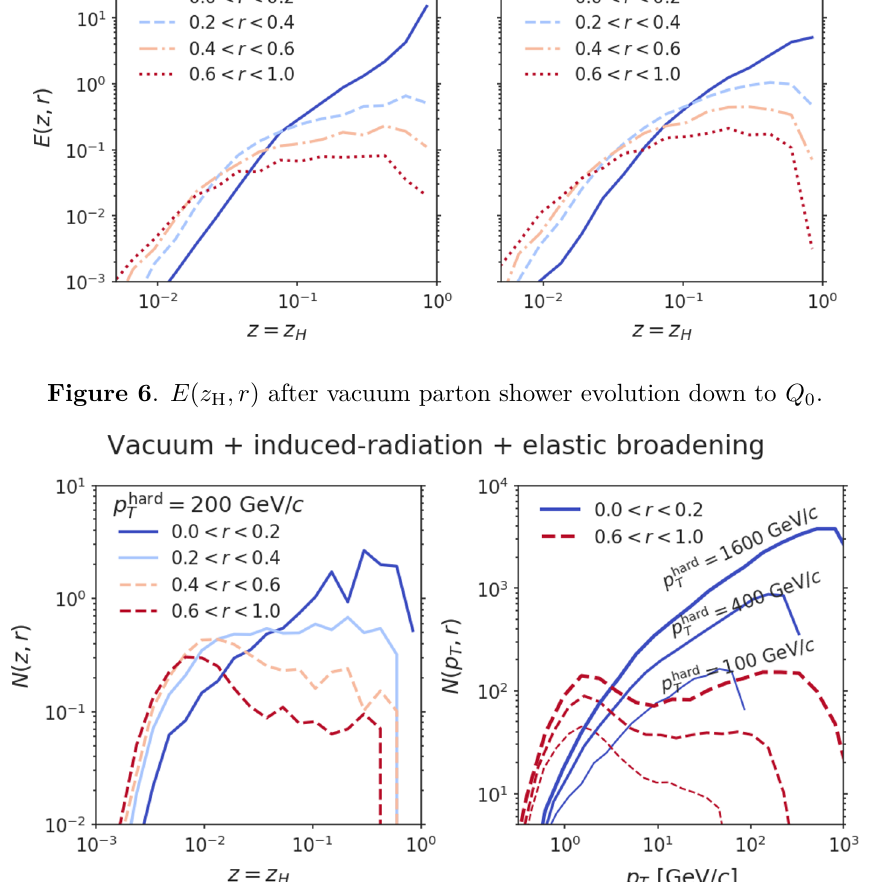
) for p hard = 200 GeV/ c at various H , r T = 100, 400, and 1600 GeV/ c T